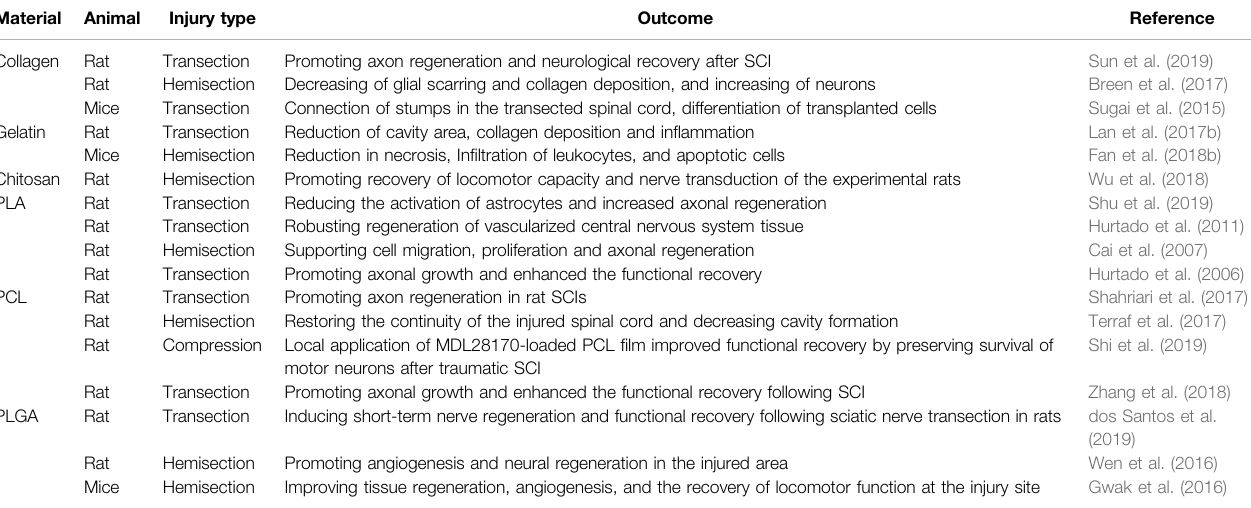
TABLE 2 | Natural and synthetic polymeric fi bers for SCI repair. Material